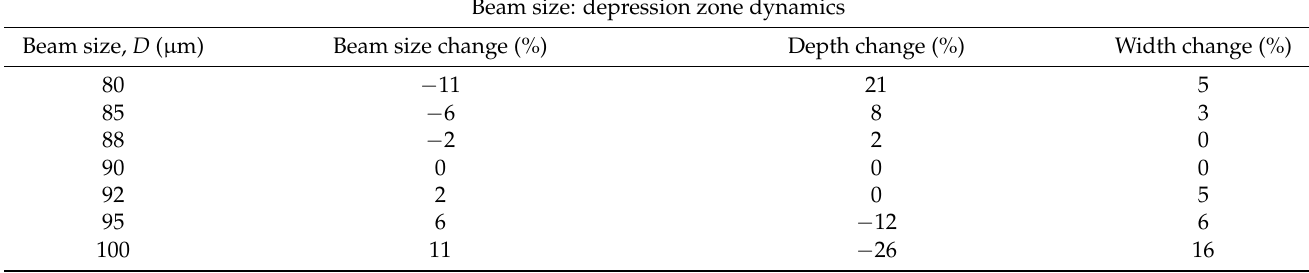
Table 3. Percent change in SLM dynamics induced by variations in laser beam size during laser